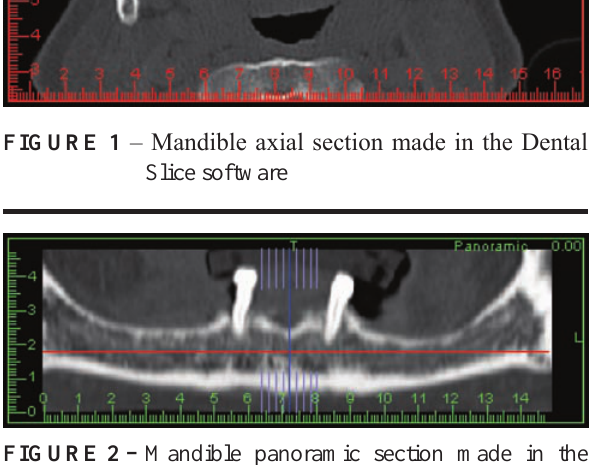
FIGURE 2 – Mandible panoramic section made in the Dental Slice